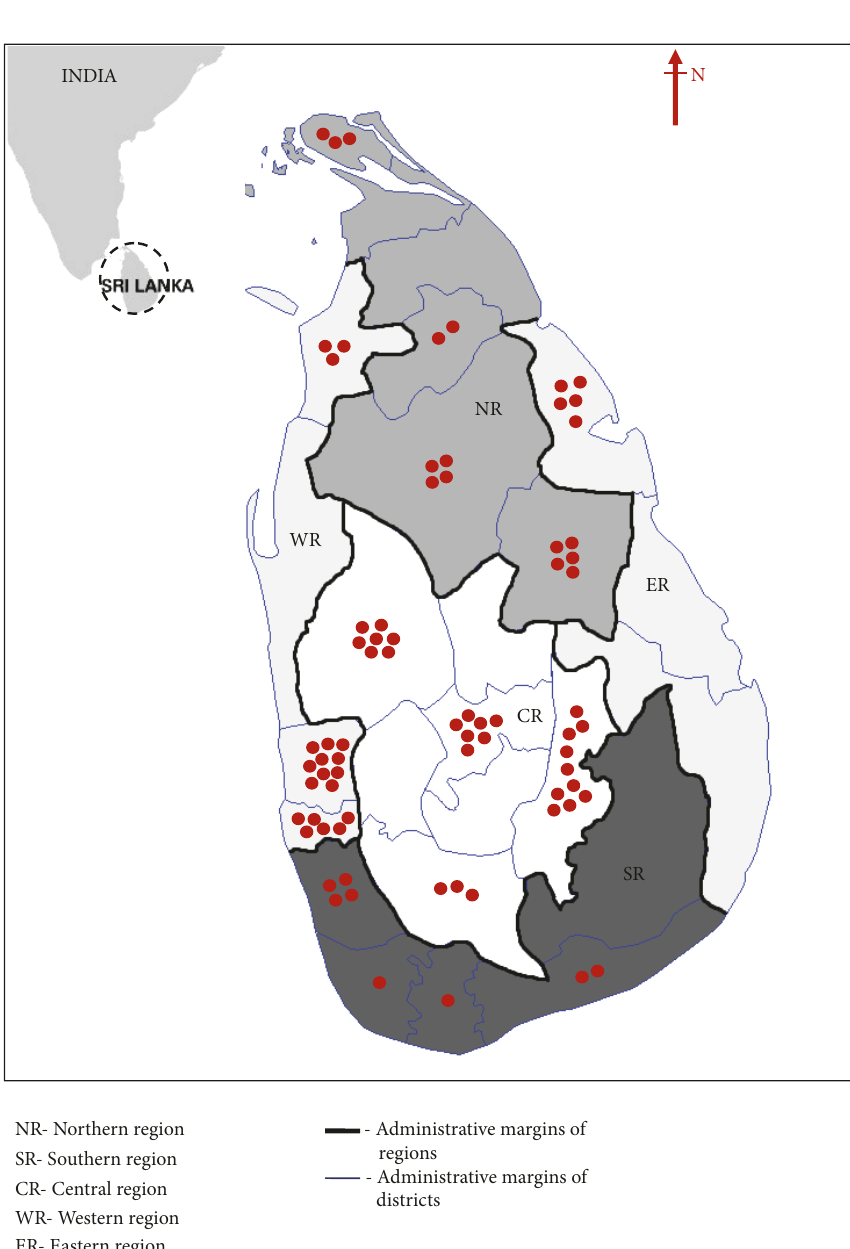
Figure 2: Distribution of atypical cases of CL within the five different geographical regions within the country. Percentagesof ACL cases were calculated based on total cases in each district. One dot represents 5%. Dot counts were calculated to the nearest total multiplications of